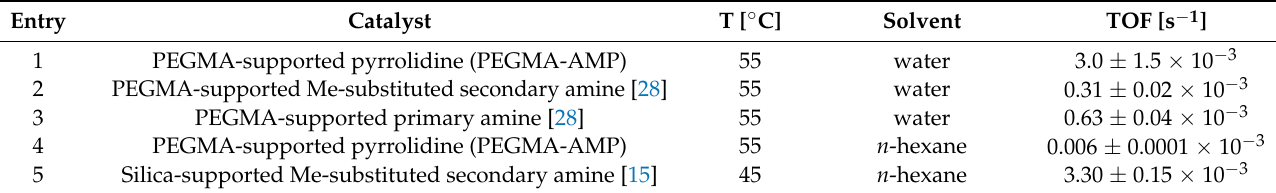
Table 3. Overview of batch screening conditions and obtained turnover frequencies (TOF) exhibited by the PEGMA-AMP catalyst, compared to PEGMA-supported methyl-substituted secondary and primary amines as reported by De Vylder et al. [28], and a silica-supported methyl-substituted secondary amine as reported by Lauwaert et al. [15]. The solvent is applied in a 50/50 vol% mixture with